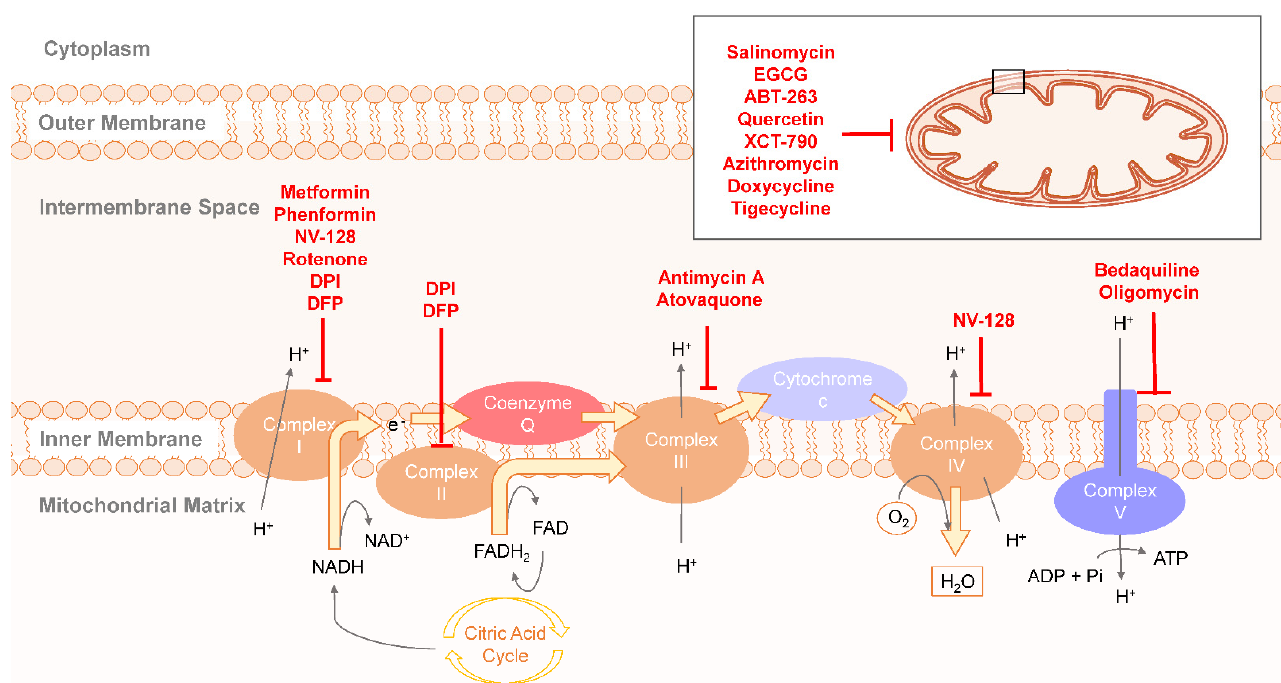
Figure 1. Electron transport chain and OXPHOS as the target of CSC metabolism. Many drugs have been used in targeting cancer stem cells (CSCs). Metformin, a well-known drug, is the inhibitor of Complex I. Phenformin, NV-128, and rotenone also block the electron transfer of Complex I. Diphenyleneiodonium chloride (DPI) and deferiprone (DFP) are the inhibitors of Complexes I and II. Furthermore, antimycin A and atovaquone target the ETC by targeting Complex III. In addition, bedaquiline, and oligomycin show their inhibitory effects against CSCs through blocking Complex V. For mitochondrial biogenesis, salinomycin, epigallocatechin-3-gallate (EGCG), ABT-263, quercetin, XCT-790, azithromycin, doxycycline, tigecycline are all effective chemical compounds or drugs that can regulate mitochondrial biogenesis.